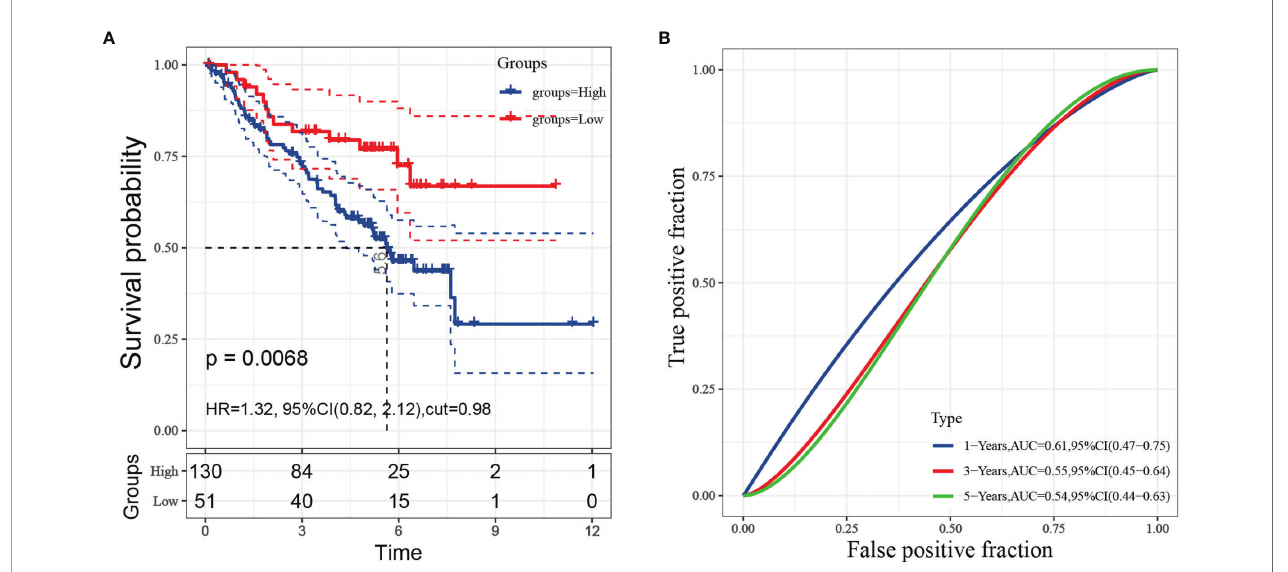
FIGURE 7 | Evaluation of risk model performance in independent datasets. ( A : Kaplan-Meier curves and univariate Cox regression of overall survival in GSE50081; B : ROC curve analyses in GSE50081).